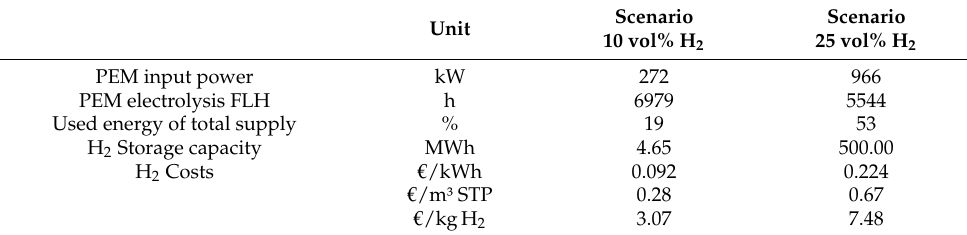
Table 4. Parameters of the optimized PtH 2 integration into oxyfuel glass-melting processes for the boundary conditions (location, renewable energy sources, TRY) with respect to cost minimization.